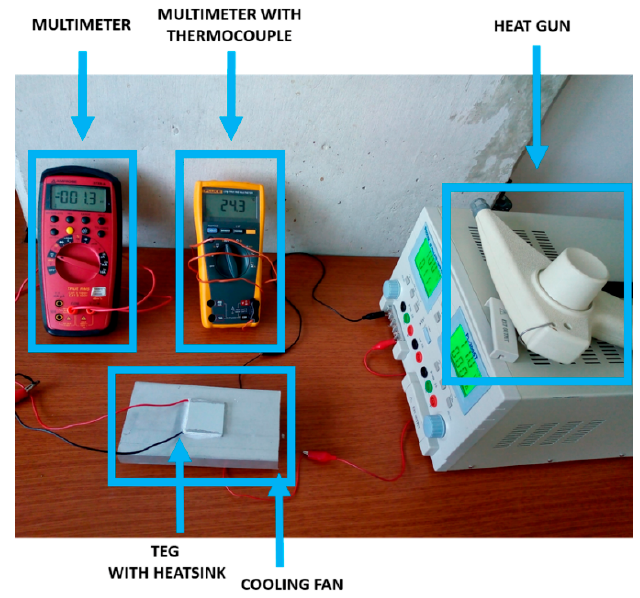
Figure 4. Experiment configuration from parameters estimation.